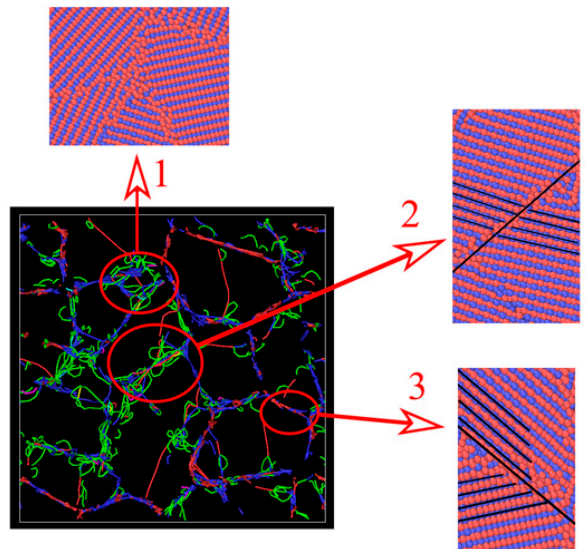
Figure 4. Dislocation extraction algorithm and atomic configuration of the equimolar Cu-Ni alloy at 5 ps.